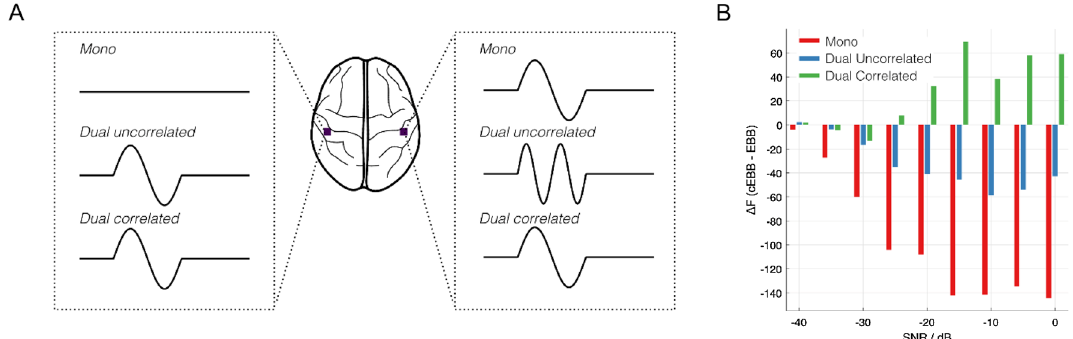
Figure 1. Depiction and model evidence results of the simulations comparing Empirical Bayesian Beamforming (EBB) to correlated EBB (cEBB) inversions. ( A ) Cartoon diagram explaining the simulation types, in this case two sources placed in Heschl’s gyri were set to be either unilateral, uncorrelated or correlated bilateral. ( B ) Model evidence comparison between the correlated and uncorrelated beamformer priors for sources simulated in Heschl’s gyri. Positive values in model evidence indicate that correlated priors (cEEB) were more likely models compared to uncorrelated ones